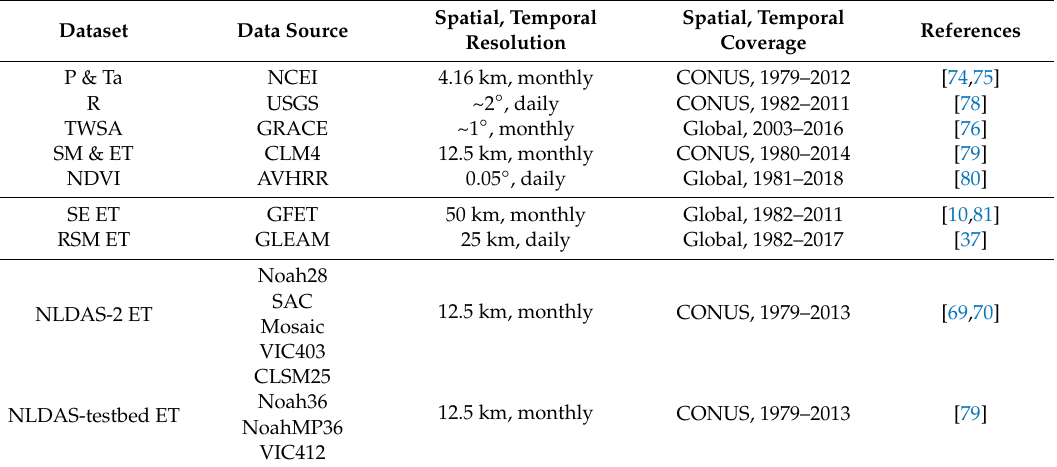
Table 2. Summary of regional datasets over the contiguous United